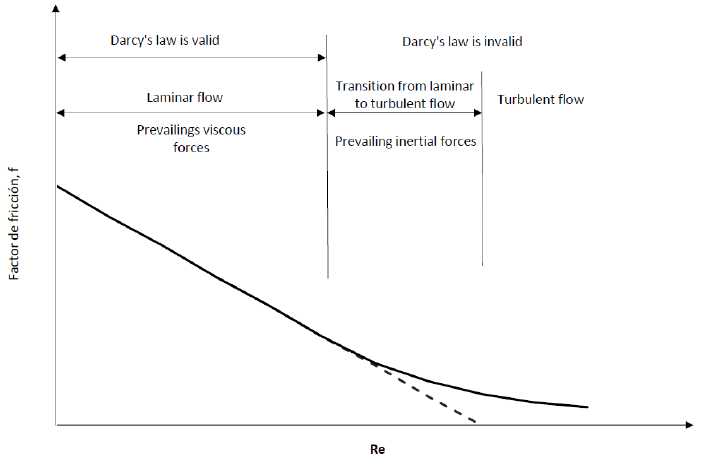
Figure 1. Schematic diagram of [ R e , f ] Equation (10). Adapted from Bear (1988) [7]. As indicated by Sabri Ergun and A. A. Orning (1949) [8] “This transition from the dominance of viscous to kinetic effects, for most packed systems, is smooth, indicating that there should be a continuous function relating pressure drop to flow